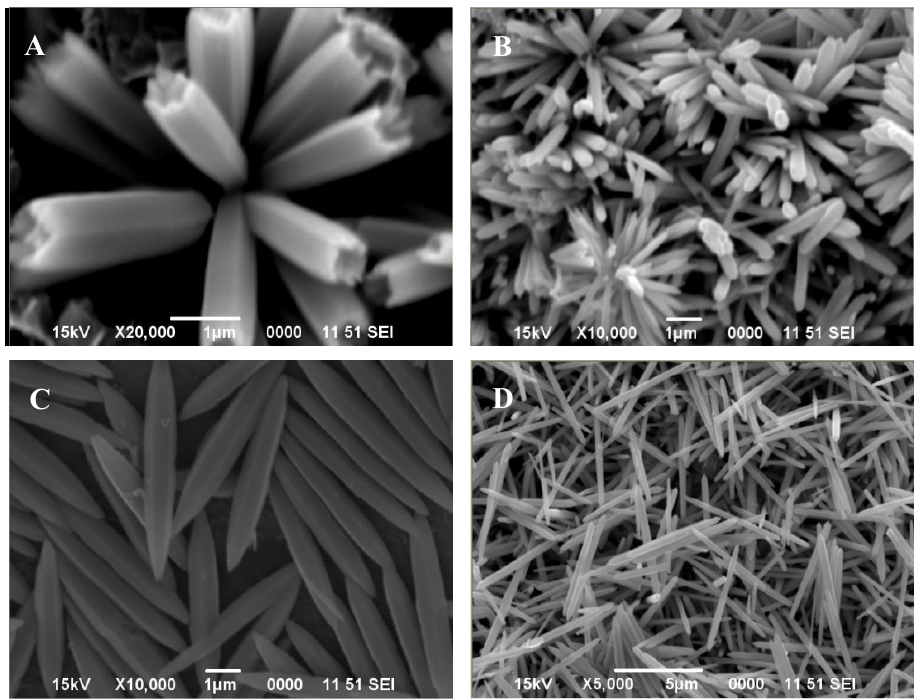
Figure 6. SEM images of the particles produced by reflux boiling for 30 min. the aqueous solutions containing: ( A ) 0.2 mol/L urea, and 0.03 mol/L zinc nitrate; ( B ) 0.4 mol/L urea and 0.03 mol/L zinc nitrate; ( C ) 0.4 mol/L urea and 0.03 mol/L zinc nitrate, with 15 vol.% ethylene glycol; ( D ) 0.4 mol/L urea and 0.03 mol/L zinc nitrate, with 4 vol.% ethylene glycol; ( E ) 0.4 mol/L urea and 0.015 mol/L zinc nitrate, with 4 vol.% ethylene